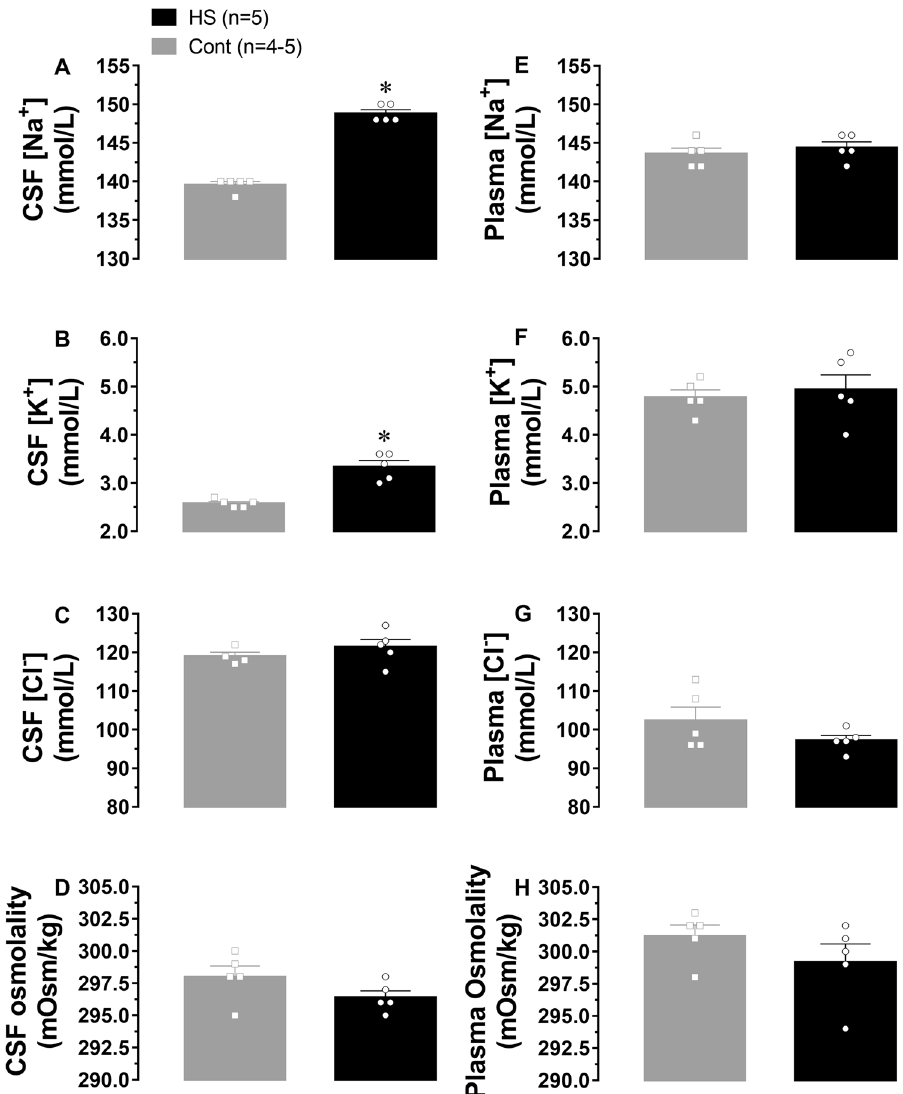
Figure 5. CSF and plasma concentration of sodium [Na + ], potassium [K + ], chloride [Cl − ] and osmolality. Panels A and E represent [Na + ] in CSF and pla s ma; ( B and F ) represent [K + ] in CSF and pla s ma; ( C and G ) represent [Cl − ] concentration in CSF and pla s ma and ( D and H ) represent osmolality measured in fresh samples. Measurements were performed in samples from HS and Cont rats on the 12 th weeks after weaning. * Different of Cont group; unpaired t -test; p <